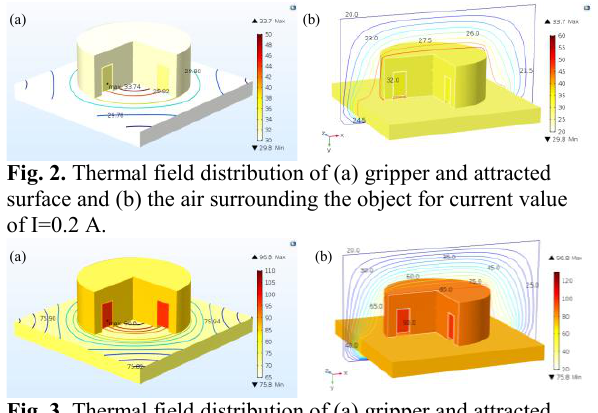
Fig. 3. Thermal field distribution of (a) gripper and attracted surface and (b) the air surrounding the object for current value of I = I N =0.494 A.